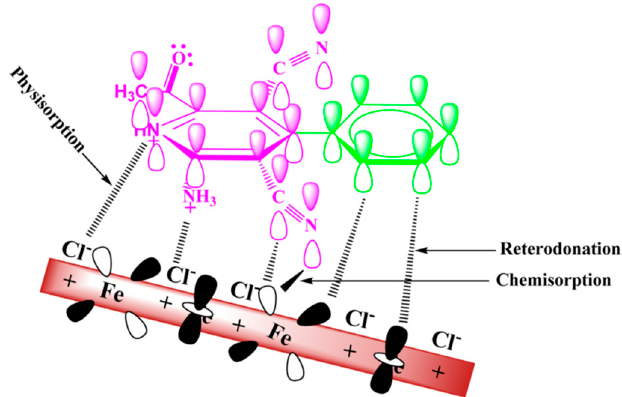
Figure 4. Schematic of adsorption and inhibition mechanism of PC molecule on mild steel in 1 M HCl [43].